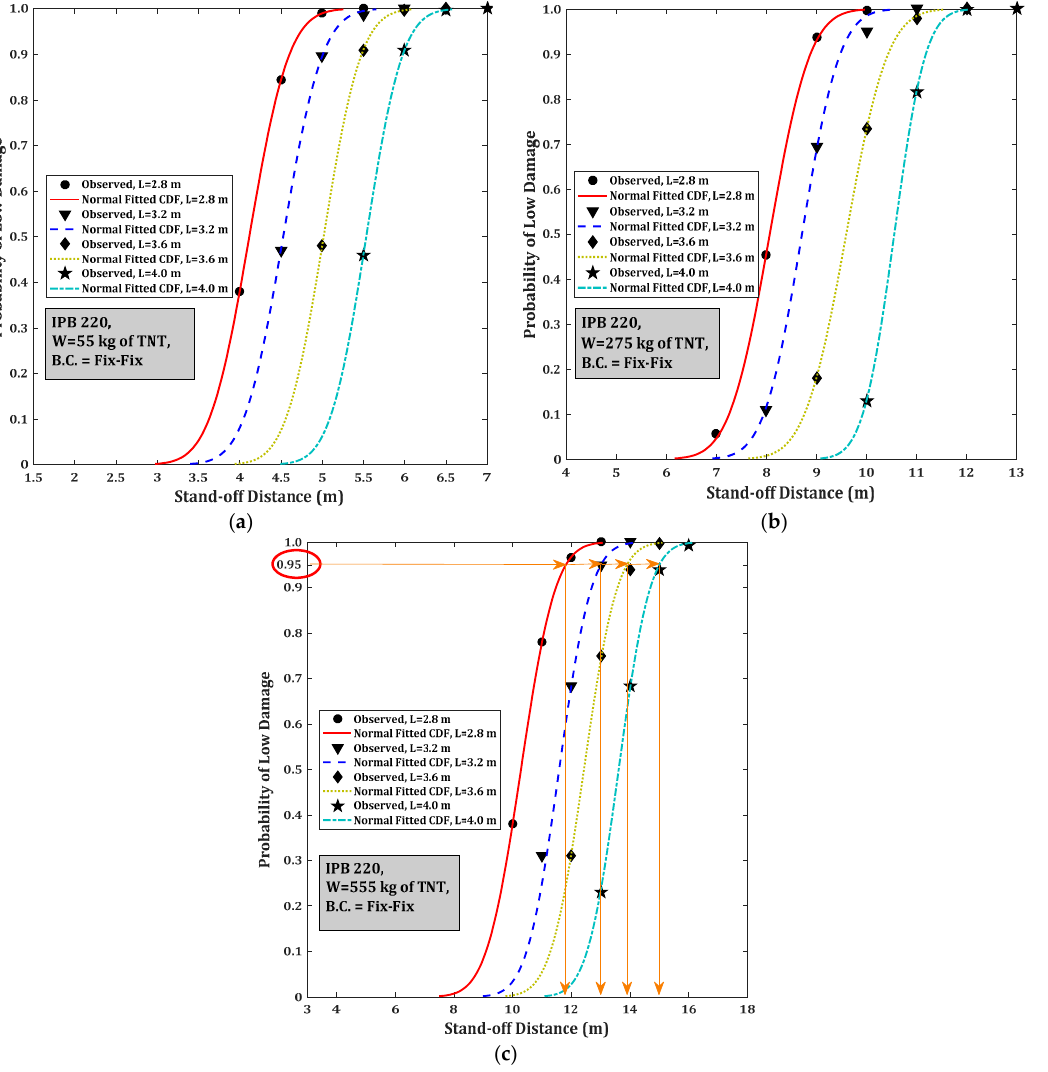
Figure 7. Curves of probability of low damage for IPB220 with fixed ends and different s lengths, subjected to: ( a ) 55, ( b ) 275 and ( c ) 555 kg of TNT It should be noted that the variability of stand-off distance is highly dependent on the position of the explosive, given that the location of a terrorist device is not a certain parameter. When the target is known, the minimum stand-off distance from a facility (building, bridge, etc.) is obtained from the knowledge of the site (roads, parking, etc.), the access control (security gates, bollards, etc.) and the perimeter security [78]. Generally, for a critical building that may represent a target for terrorist attacks with variable and portable explosive weights (i.e., by human and different vehicles), the minimum stand-off distance can be easily found using the proposed strategy. Such a minimum stand-off dis- tance can be thus used to provide appropriate access control and security guards around the building, thus ensuring that the risk of damage for the structural members in the first stage and the progressive collapse can be reduced.